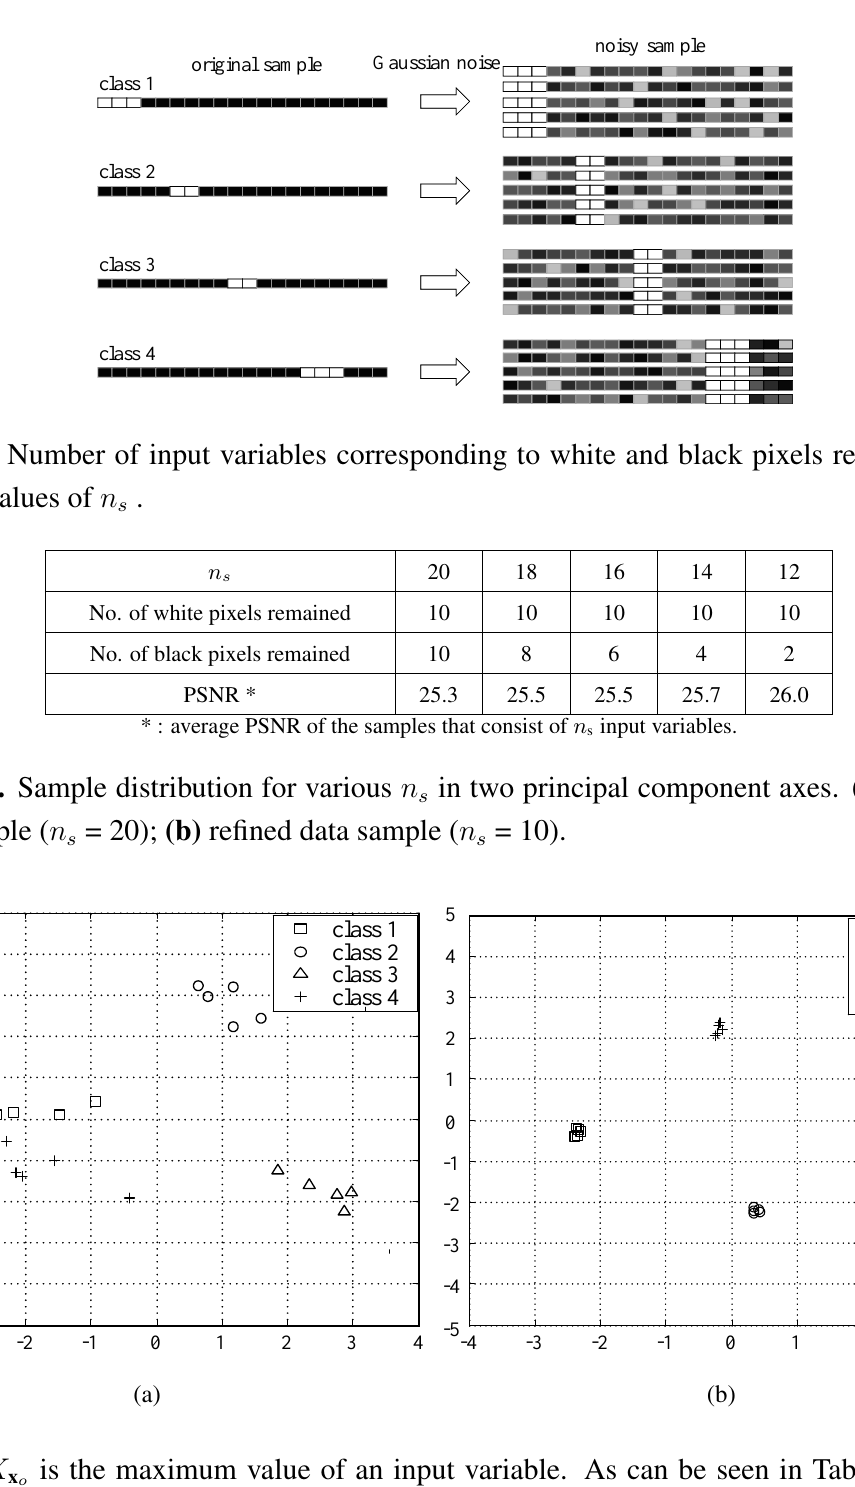
Figure 3. The vector sample from four classes (the left samples: without noise, the right samples: with Gaussian noise).